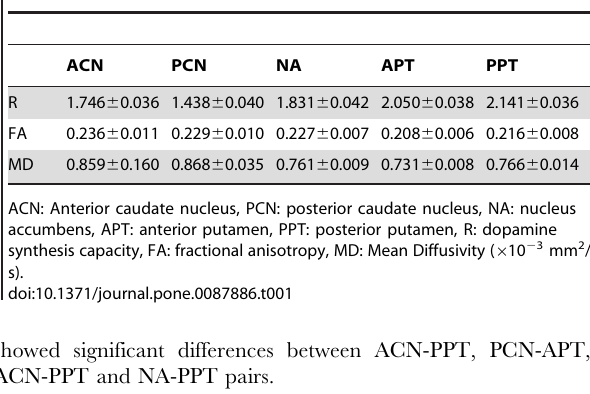
Table 1. Average and standard error of mean of dopamine synthesis capacity, fractional anisotropy and mean diffusivity in striatal subregions.